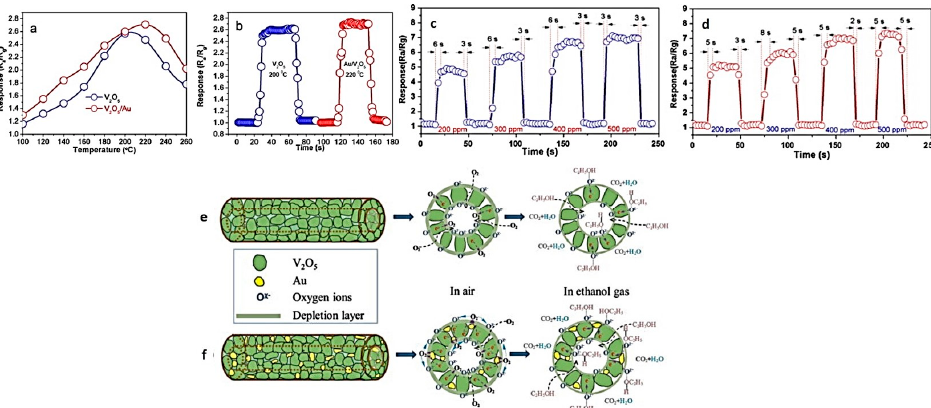
Figure 13. ( a ) Temperature-dependent responses of V 2 O 5 and Au/V 2 O 5 nanotubes against ethanol; ( b ) response–recovery behaviors of V 2 O 5 and Au/V 2 O 5 nanotubes exposed to ethanol. The dynamic ethanol sensing transients of ( c ) V 2 O 5 and ( d ) Au/V 2 O 5 sensors when ethanol concentration